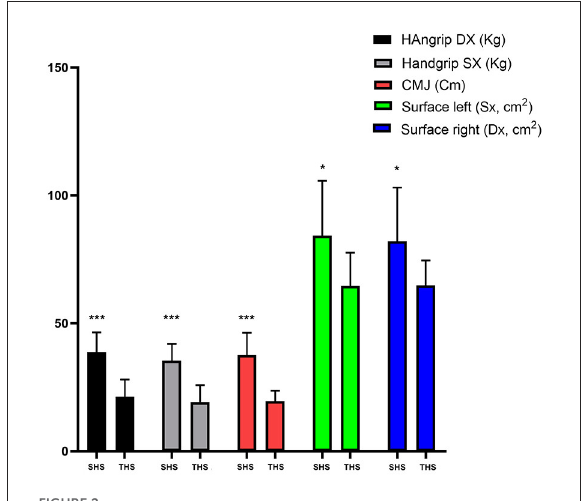
FIGURE2 Analysis between SHS (T0) vs. THS (T0). * p < 0.05; ** p < 0.01; *** p < 0.001.